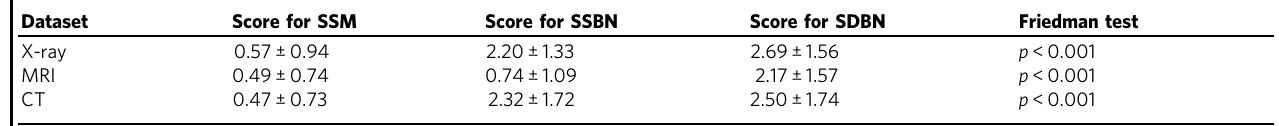
The scale ranges from 0 (useless) to 5 (saliency map points clearly and unambiguously to the correct pathology). In total 100 images were rated by 6 radiologists for each dataset. One-sided Friedman tests were used to the p -value. Exact p -values are 1.0×10 − 160 , 1.7×10 − 118 , and 7.0×10 − 150 for X-ray, MRI, and CT images. SSM saliency maps of standard models, SSBN saliency maps of adversarially trained models with a single batch norm, SDBN saliency maps of adversarially trained models with dual batch